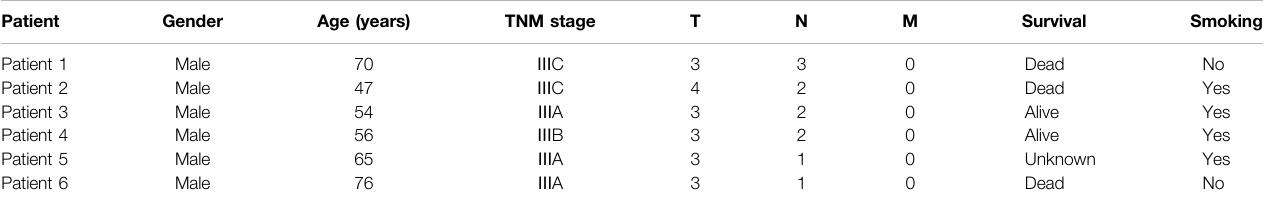
TABLE 2 | Summary of the general clinical information of EC